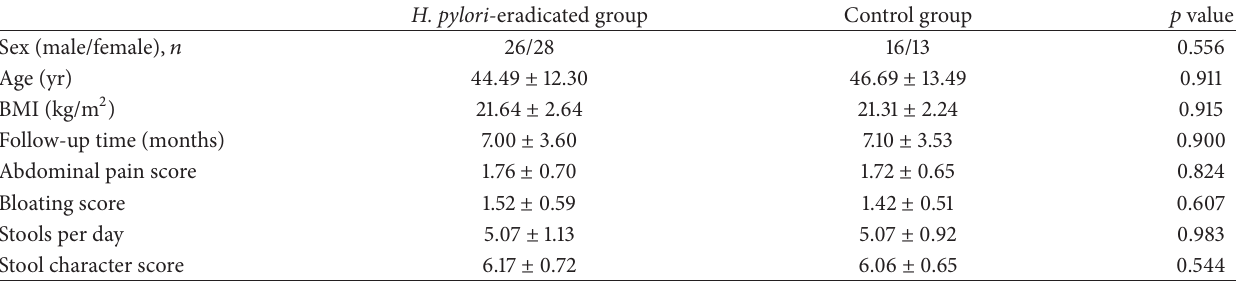
Table 1: Baseline characteristics in the H. pylori -eradicated group and the control group in patients of follow-up.